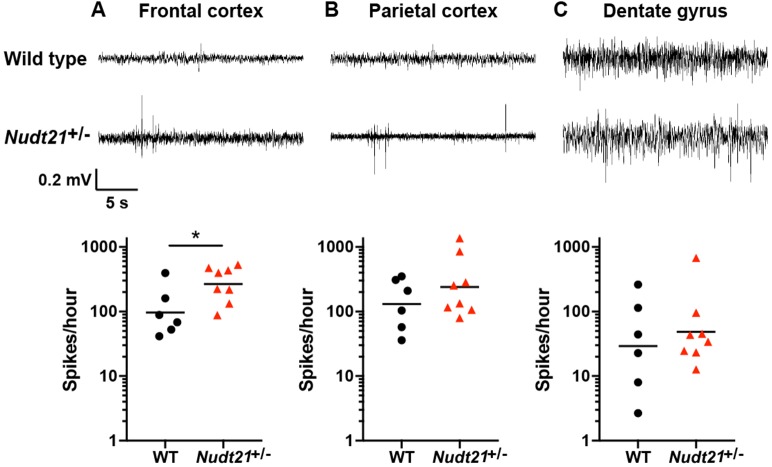
Nudt21+/-mice have increased cerebral spike activity.(A) 57-week-old Nudt21+/- mice have significantly increased spike activity in the frontal cortex by EEG (p=0.029), but not in the parietal cortex (B) and dentate gyrus (C). Representative traces are on top and spike count summaries below. All data analyzed by two-tailed Mann-Whitney test. Central tendency lines show the geometric mean. *p<0.05.